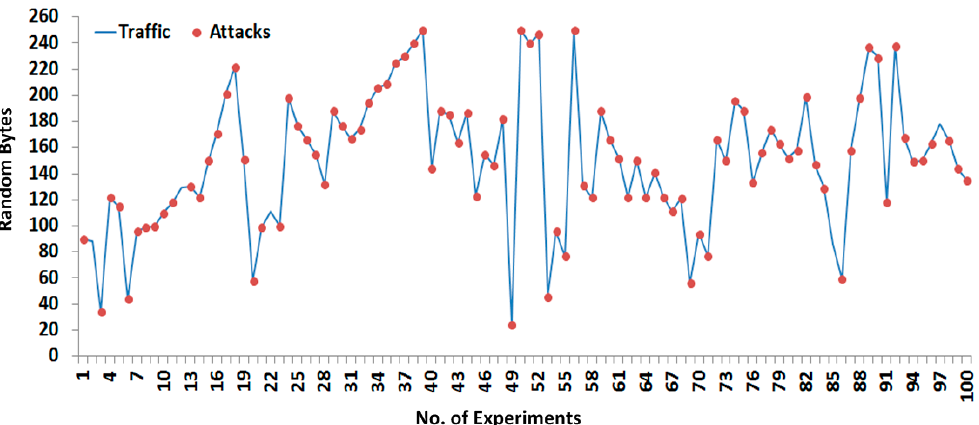
Sensors 2016 , 16 , 322